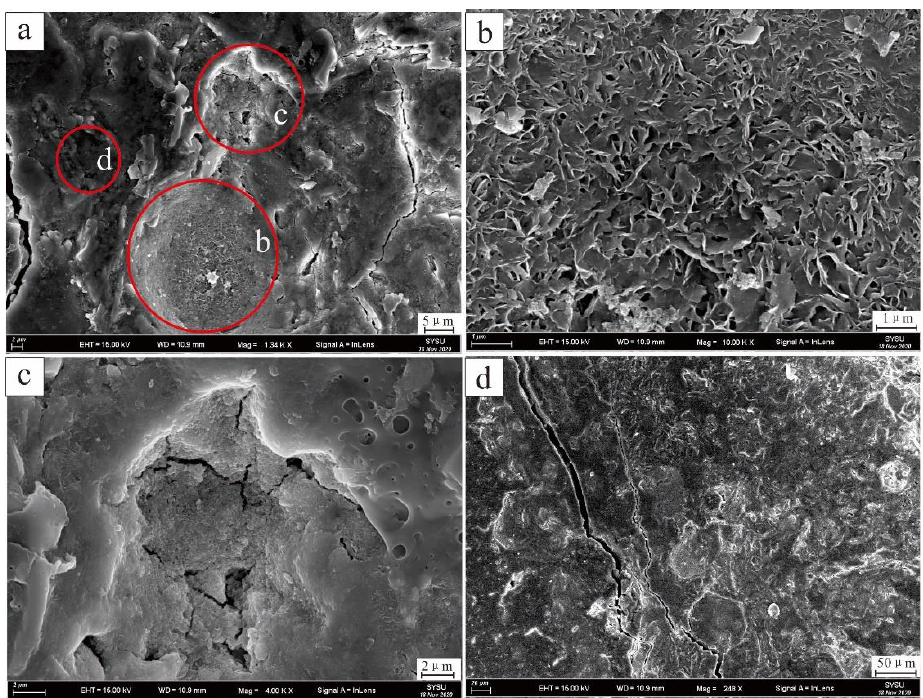
Figure 7. Division map of polymetallic nodules EDS scan area. ( a ) total area; ( b ) region 1; ( c ) region 2; ( d ) region 3. Table 1. Normalized mass concentration (The value is the percentage of content).